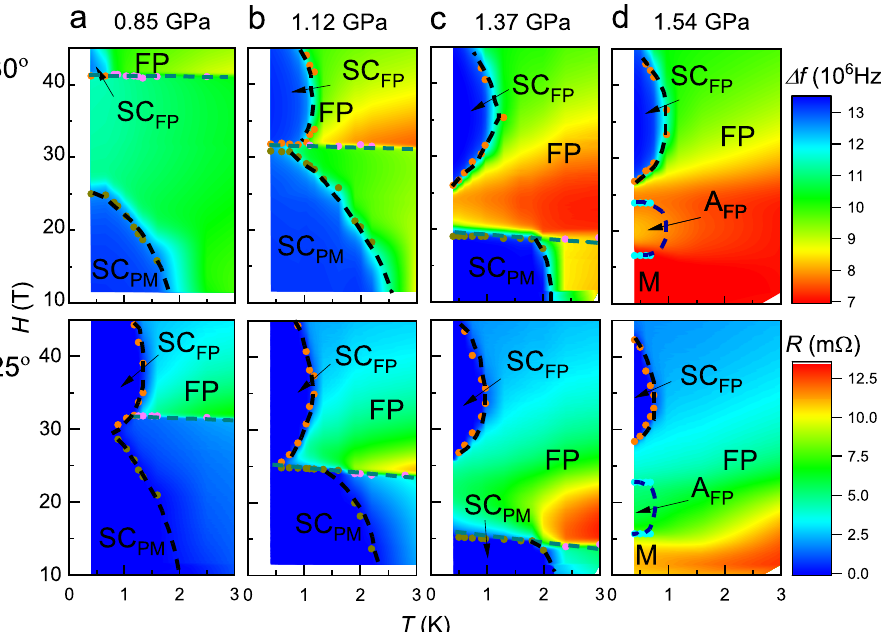
Fig. 2 High- fi eld TDO frequency and resistance at different pressures. TDO frequency is sensitive to the change of both electrical resistance and magnetic susceptibility of the sample. Magnetic fi eld is applied at 30° from b axis toward c axis for TDO measurement, and 25° from b axis toward c axis for resistance measurement. a In the low-pressure region, H FP serves as a lower bound to SC FP , whose dome is cut off discontinuously. b At crossover pressures P x , H FP falls approximately between SC FP and SC PM , whose ranges of stability would otherwise overlap. c Above P x , H FP serves as the upper fi eld limit for SC PM . d Above P c , long-range ordered magnetism M sets in while SC FP survives and the anomalous feature A FP emerges as a local maximum in Δ f . Solid dots are from experimental data, dashed lines are guide for the eye. Note that TDO and resistance measurements are performed for slightly different magnetic fi eld direction, which leads to the slightly different phase diagrams for each